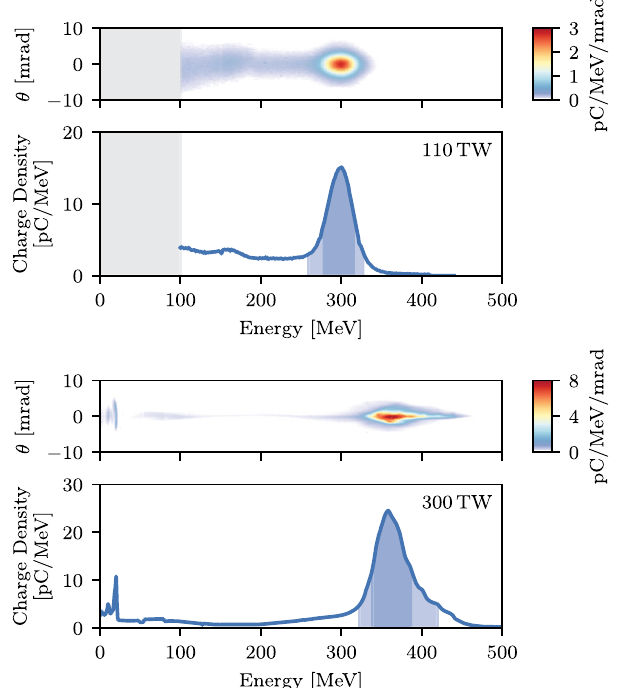
FIG. 6. Electron spectra from shock-front injection, plotted on a linear energy scale. Top: 110-TW case — The total charge above 100 MeV is 1.2 nC, and the peak contains 608 pC within the 20% width (lighter shaded area) and 470 pC within the FWHM interval (darker shaded area). The spectral charge density reaches 15 pC MeV − 1 . Electrons below 100 MeV are not detected. Bottom: 300-TW case — The total charge above 100 MeV is 1.74 nC. The peak contains a charge of 1.3 nC (lighter shaded area), with 0.94 nC in the FWHM (shaded area). The peak charge density exceeds 24 pC MeV − 1